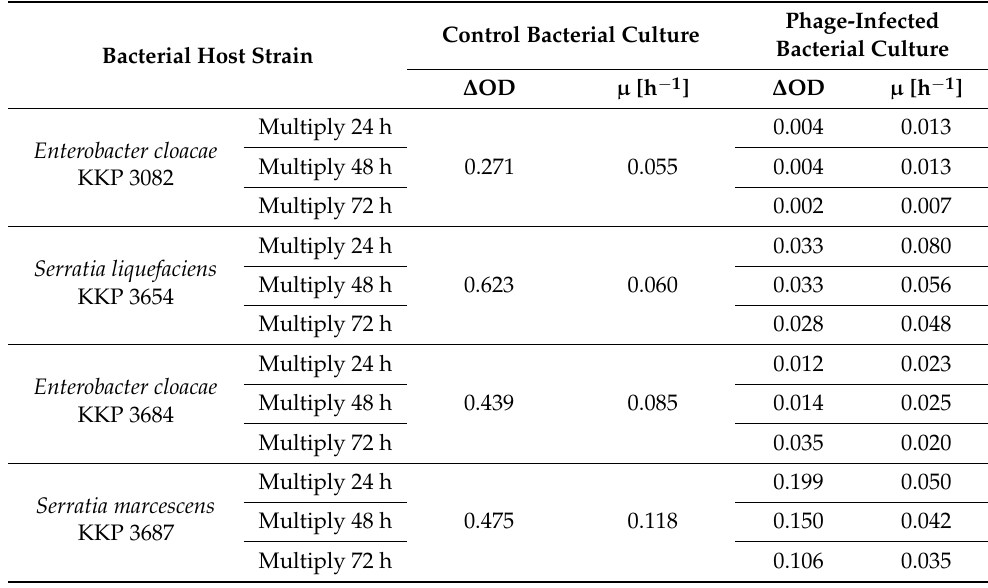
Table 4. Values of specific growth rate coefficient of tested bacterial cultures after addition of phages multiplied for 72 h ( n = 10). Control Bacterial Culture Bacterial Host Strain